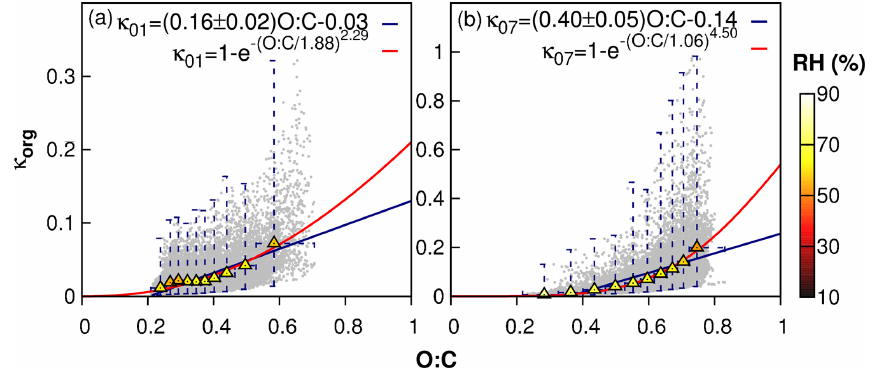
Figure 4. The correlation of hygroscopicity of organic aerosol ( κ org ) and the O : C ratio in nine representative cities – Shenyang (SS), Beijing (BJ), Jinan (JN), Zhengzhou (ZZ), Xi’an (XA), Nanjing (NJ), Shanghai (SH), Chengdu (CD), and Guangzhou (GZ) – in January (a) and July (b) of 2013. O : C ratios are categorized into 10 bins. In each bin, the ranges of O : C and κ org are represented by bars. The mean values of O : C and κ org are represented by triangles colored by the averaged RH of each bin. The relationship between κ org and O : C is fitted by a linear function with reduced major-axis regression (blue lines) and an exponential function (red lines), respectively. κ 01 and κ 07 represent the fitted correlation for January and July,